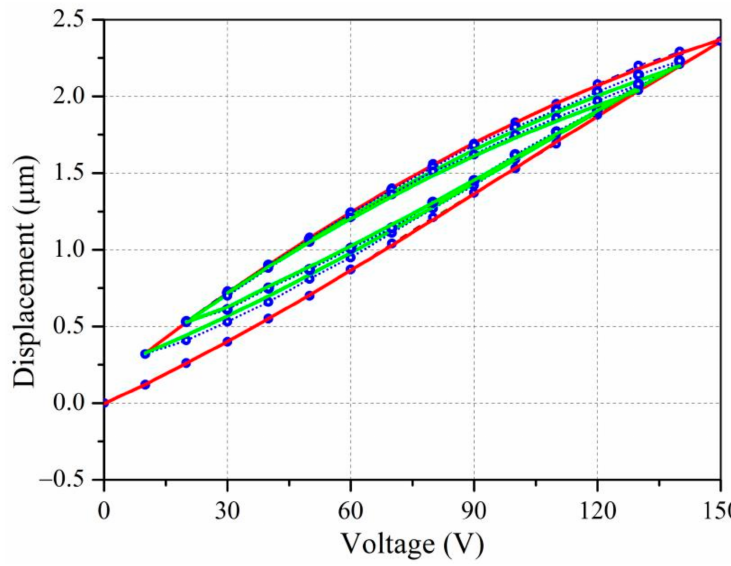
Figure 4. The inner loop model curves of the piezoelectric